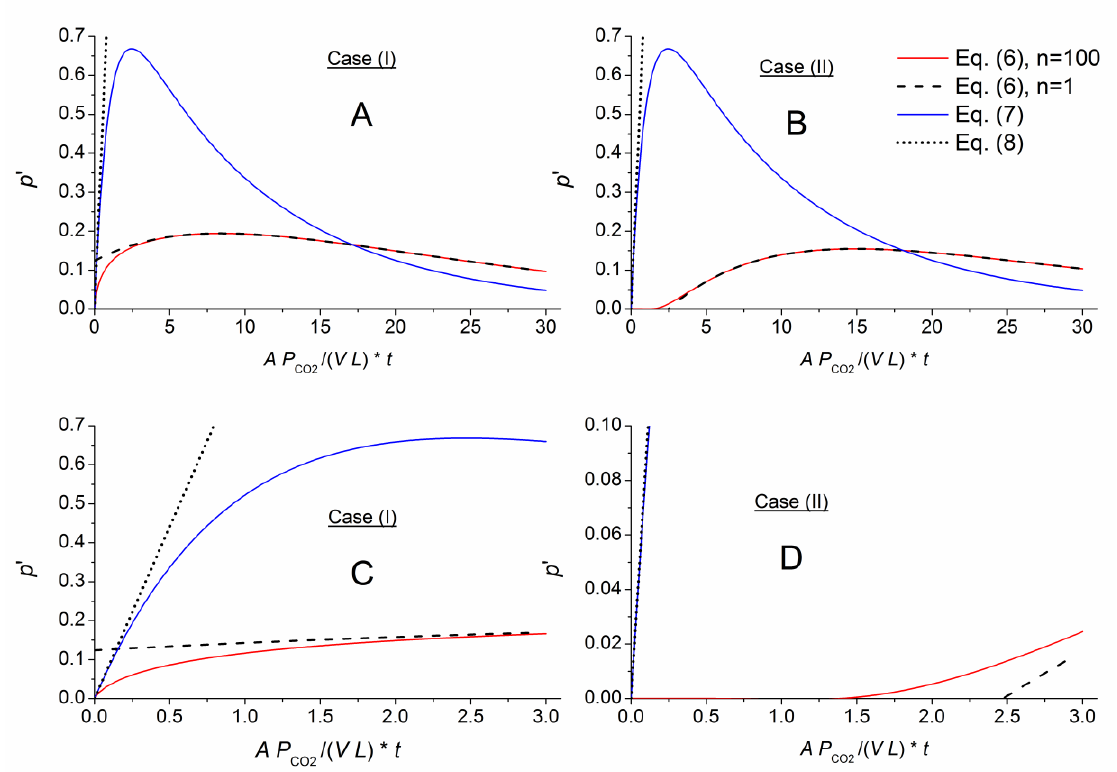
Figure 5. Comparison of the exact and approximate solutions for 10/  VAL (same scenario described for Figure 3; note that the scaling in D differs from that of the other